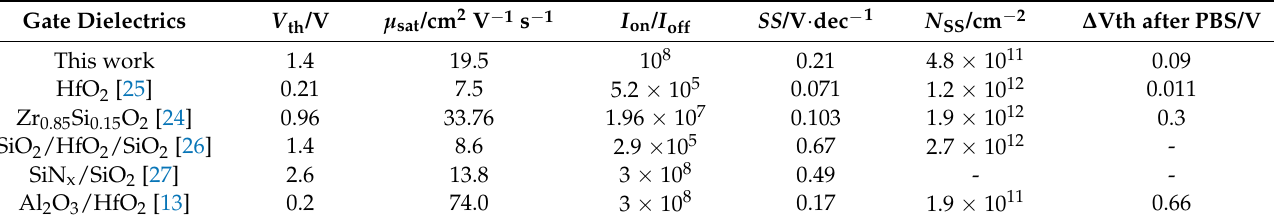
Table 4. The electrical parameters of a-IGZO TFTs with different insulating layers published in recent years. Gate